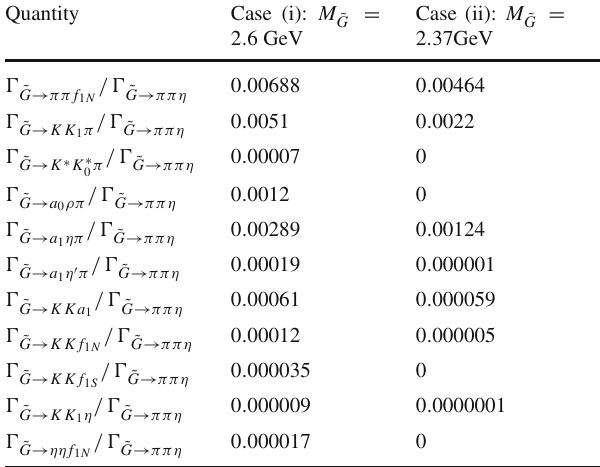
Table 4 Branching ratios for the decay of the pseudoscalar glueball ˜ G into a scalar, a pseudoscalar, a vector and an axial-vector meson